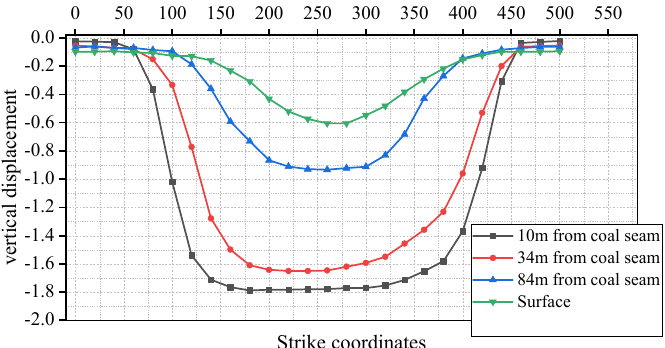
Figure 5. Vertical displacement of different overlying strata layers.